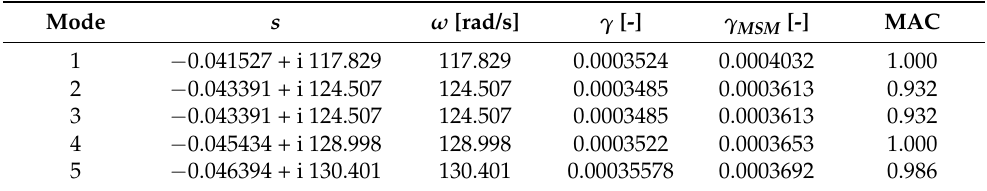
Table 6. Dome 2—NEP eigenvalues, natural frequency, non-dimensional damping ratio and MAC— the 1.0 cm-thick VE layer.